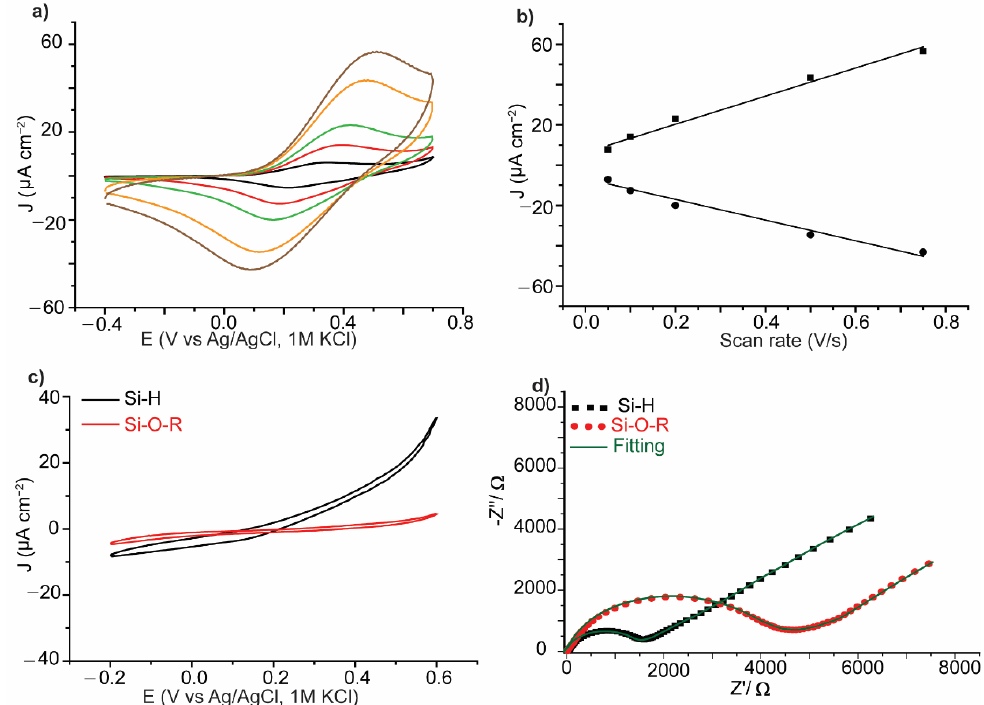
Figure 3. Electrochemical characterization of the formed self-assembled monolayers (SAMs). ( a ) Cyclic voltammograms at different scan rates for a SAM of 1 on Si–H, black: 0.05 Vs − 1 , red: 0.1 Vs − 1 , green: 0.2 Vs − 1 , orange: 0.5 Vs − 1 , brown: 0.75 Vs − 1 . ( b ) Evolution of the peak current vs scan rates, dots are data points and lines are linear fitting. ( c ) Cyclic voltammetry (CV) wave for the formed SAM of 2 on Si–H (red) as compared to a bare Si–H electrode in NaClO 4 (1.0 M) electrolyte, showing that the bare Si is more prone to oxidation than the monolayer-protected surface. ( d ) Nyquist plot of the electrochemical impedance spectroscopy (EIS). measurement for a SAM of 2 on Si–H, measured in a solution of ruthenium hexamine (10 mM) in 0.5 M KCl. Dots (red and black) represent the raw data and green line represents the Randles circuit fitting. R ct for Si–H ~ 1187 Ω and for Si–O–R surface ~4571 Ω .